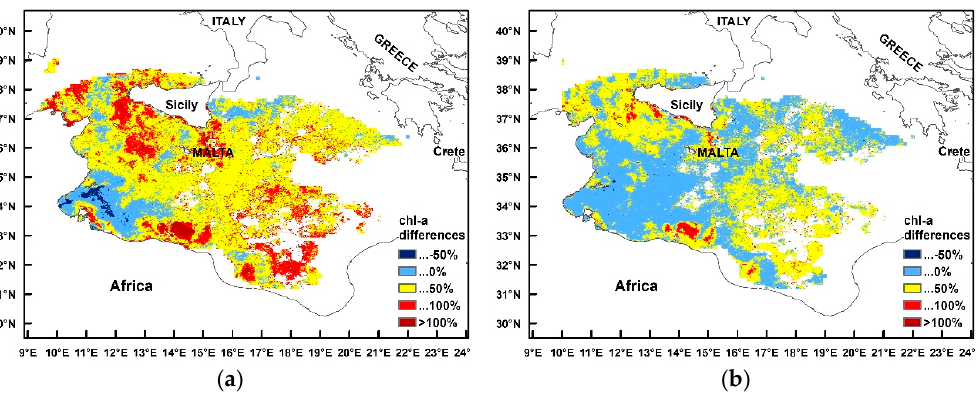
Figure A2. ( a ) Chlorophyll percentage differences between the week after the event (19–26 December 2005) and the week before the event (3–10 December 2005); ( b ) Chlorophyll percentage differences between the week after the event (19–26 December 2005) and the climatological mean values for December.